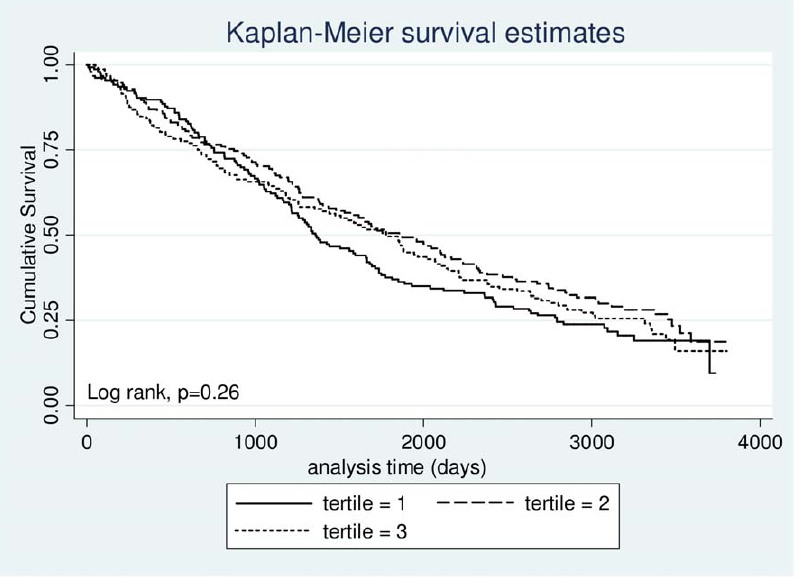
Figure 2. Three-year survival according to levels of serum 25-OHD distributed on tertiles. Differences between groups were examined using a log-rank. Result is displayed as a p value in the lower left corner.